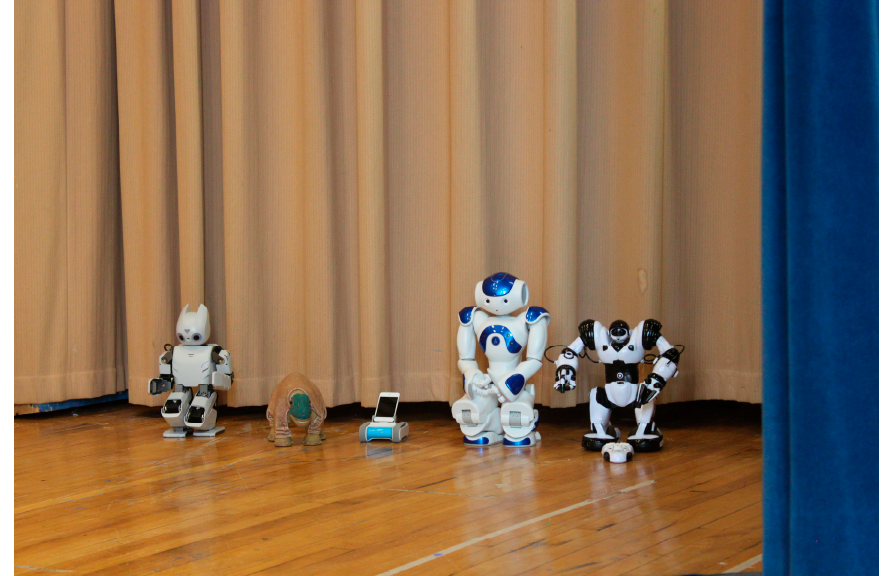
Figure 1. Robot theater program as part of an afterschool program at local elementary school. Children wrote the scenario, made props, and played live theater with robots.